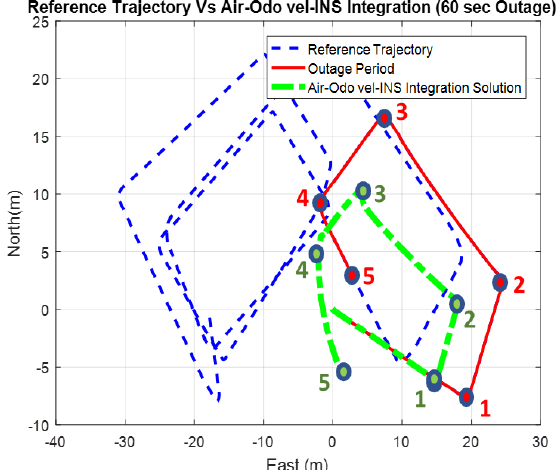
Figure 13. Solution of integrating Air-Odo alone with additional weight and INS during 60 Secs of GNSS signal outage.